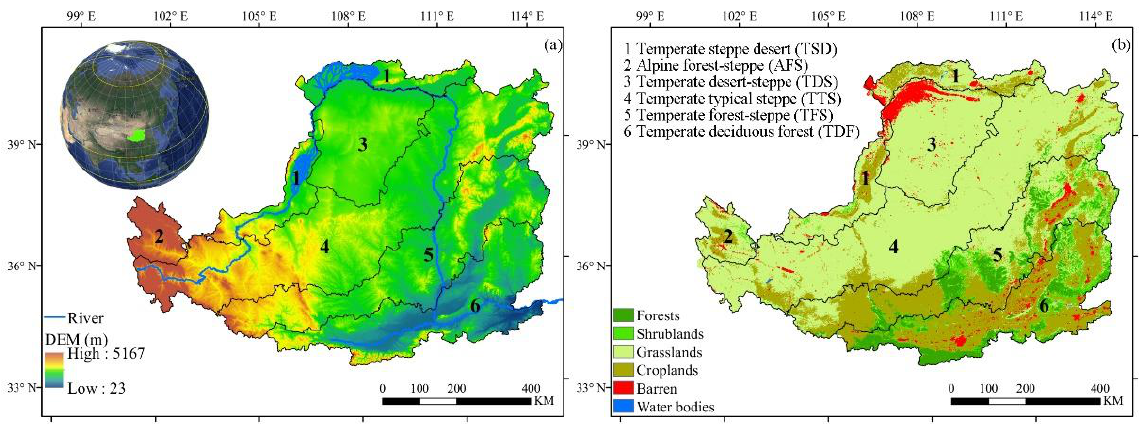
Figure 1. Map of location ( a ) and land cover ( b ) of the Loess Plateau in China. Table 1. Climate conditions and vegetation types in the sub-regions in 2020. Sub-Regions Area (km 2 )